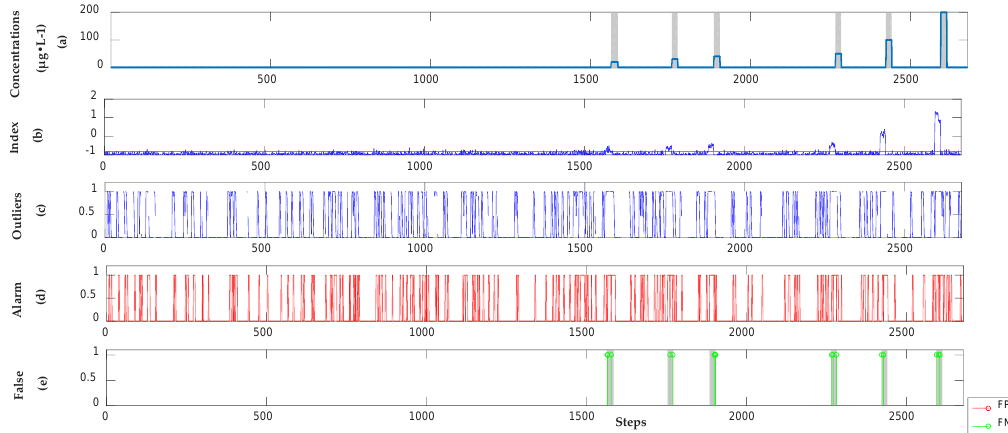
Figure 7. The detection results of resorcinol in the semi-supervised model. ( a ) Location and concentration of each event; ( b ) Alarm signals, which exceeded the threshold shown as the red dotted line; ( c ) Outliers obtained by using SVR; ( d ) Alarm sequences triggered by Sequential Bayesian; ( e ) FP points and FN points compare with real categories.